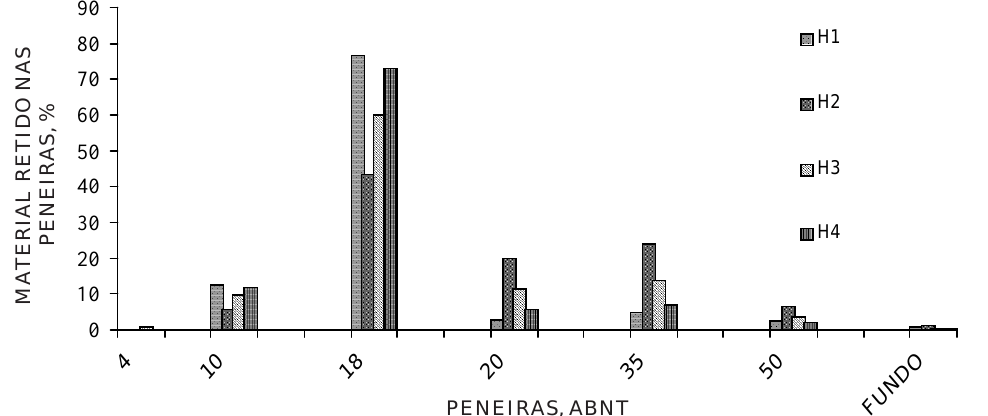
Figura 7. Granulometria dos materiais nos tratamentos, conforme as peneiras utilizadas ABNT 4, 10, 18, 20, 35 e